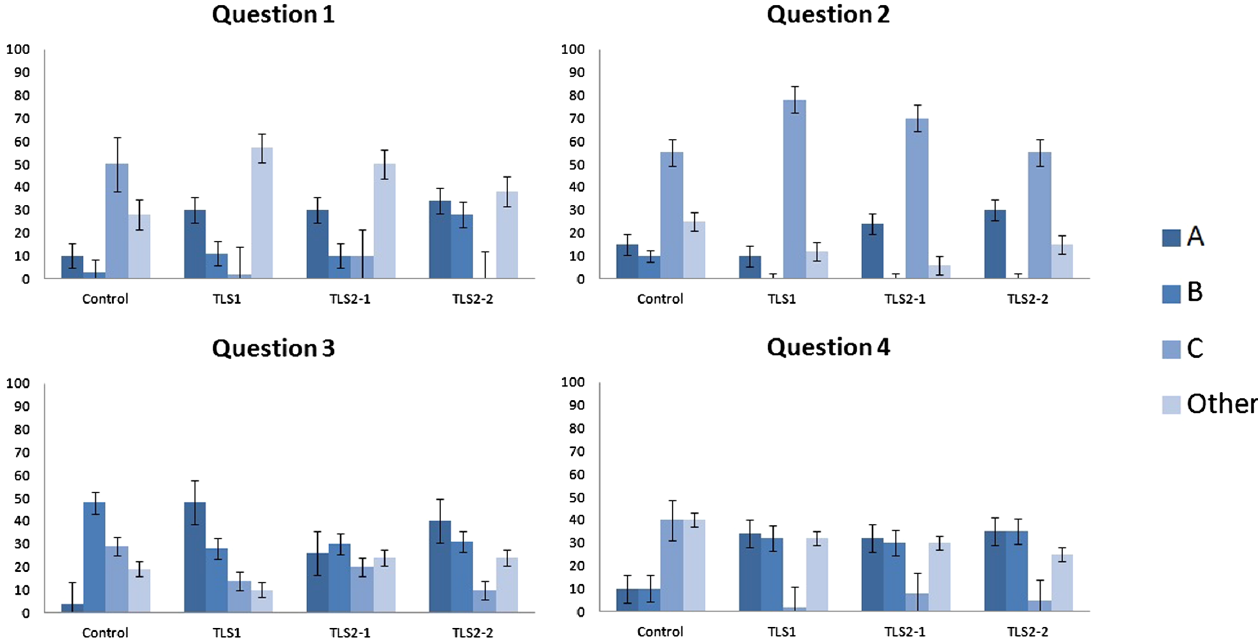
FIG. 7. Prevalence of responses (in percent) to four questions by students in the control group, the group that followed TLS1, and the groups that followed TLS2 (TLS2-1 and TLS2-2). Category A comprises correct answers based on scientific explanations. Answers in category B use scientific arguments but answer the question incorrectly or incompletely. In category C nonscientific explanations or descriptions of the phenomena are included. The “ others ” category comprises incoherent and blank